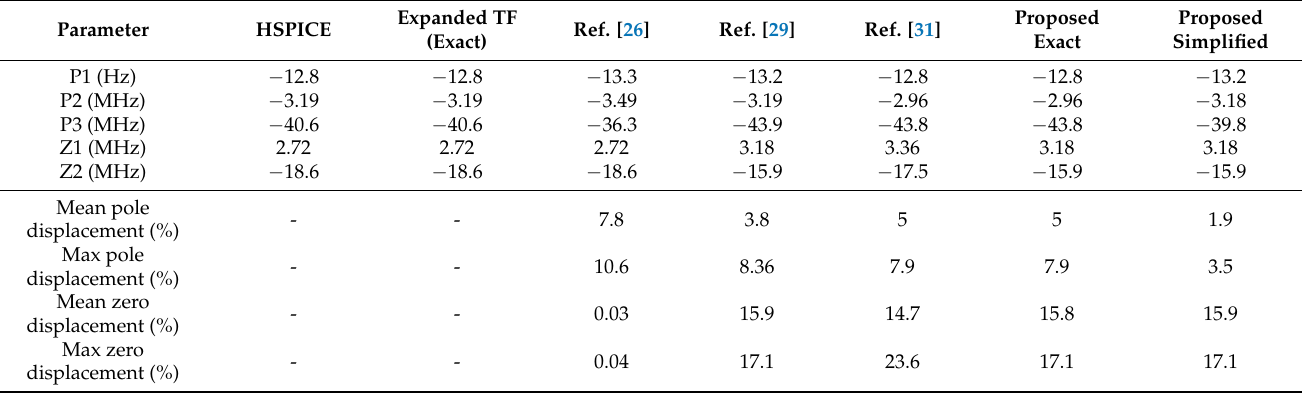
Table 5. Numerical results for Circuit